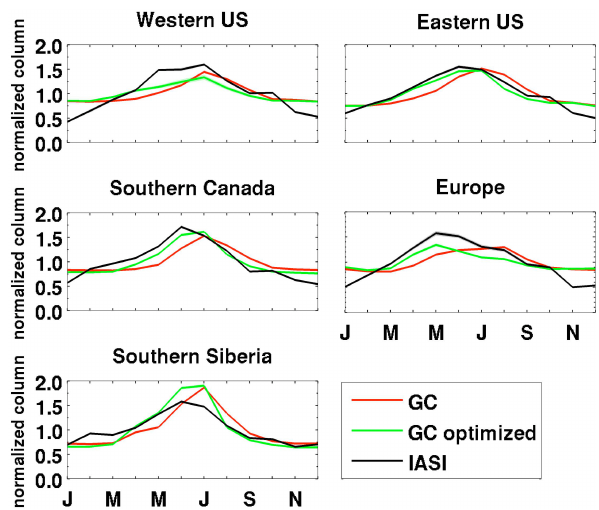
Fig. 8. Seasonal cycle in atmospheric methanol over midlatitude regions as measured by IASI (black) and predicted by the GEOS- Chem base-case (red) and optimized (green) simulations. Data are for 2009 and are normalized by the annual mean in each case. Lines show the mean for each of the midlatitude regions of Fig.